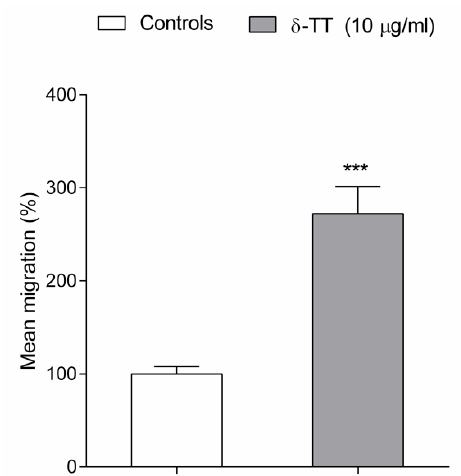
Figure 4. δ -TT (10 μ g/mL) promotes the BMSC cell migration in a Boyden chamber assay. BMCS were exposed to δ -TT 24 h before and during the micro-chemotaxis assay. The migrated cells were counted by selecting three random fields at 10 × or 20 × objective on an optical microscope. Data are reported as mean percentage of migrated δ -TT exposed cells versus control cells. *** p < 0.001 vs. controls.